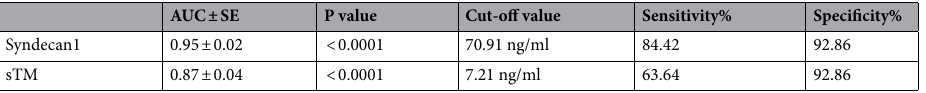
Table 3. Receiver operating characteristic (ROC) analysis for Syndecan1 and sTM in Sepsis. sTM serum thrombomodulin.